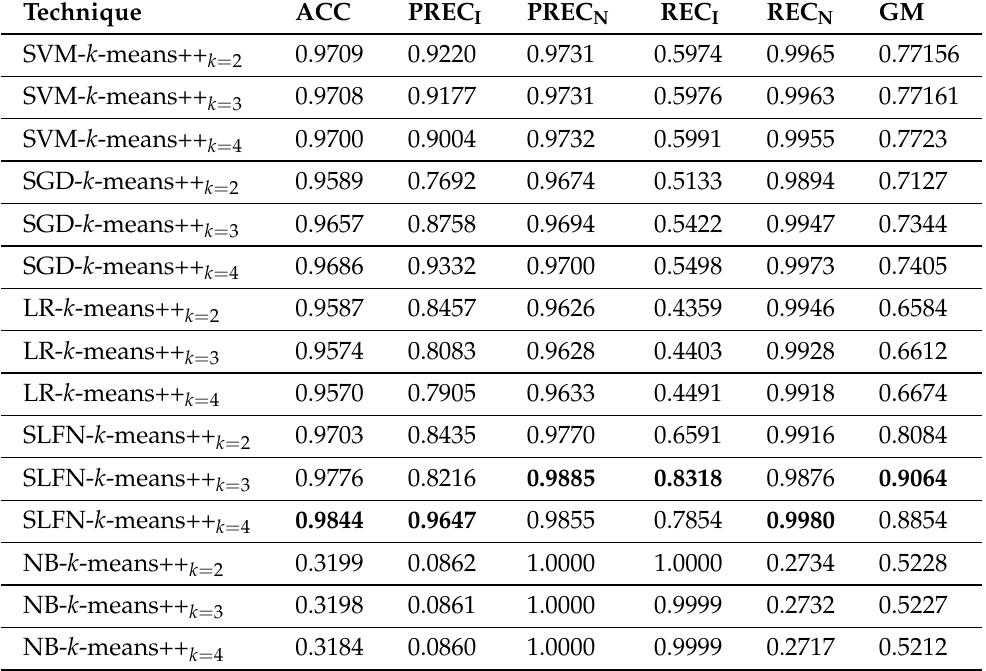
Table 2. Evaluation of the framework with basic classifiers including SVM, SGD, LR, and SLFN with the values of 2, 3, and 4 for k